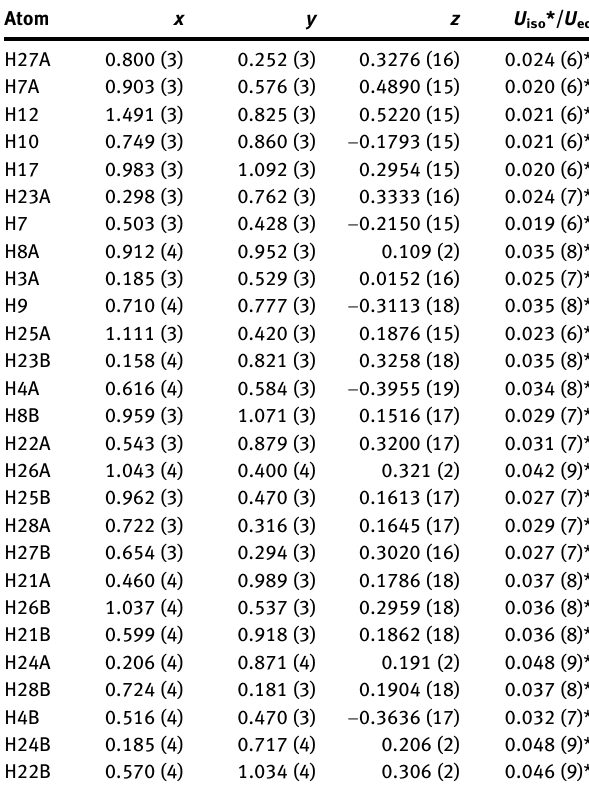
Table  : Fractional atomic coordinates and isotropic or equivalent isotropic displacement parameters (Å 